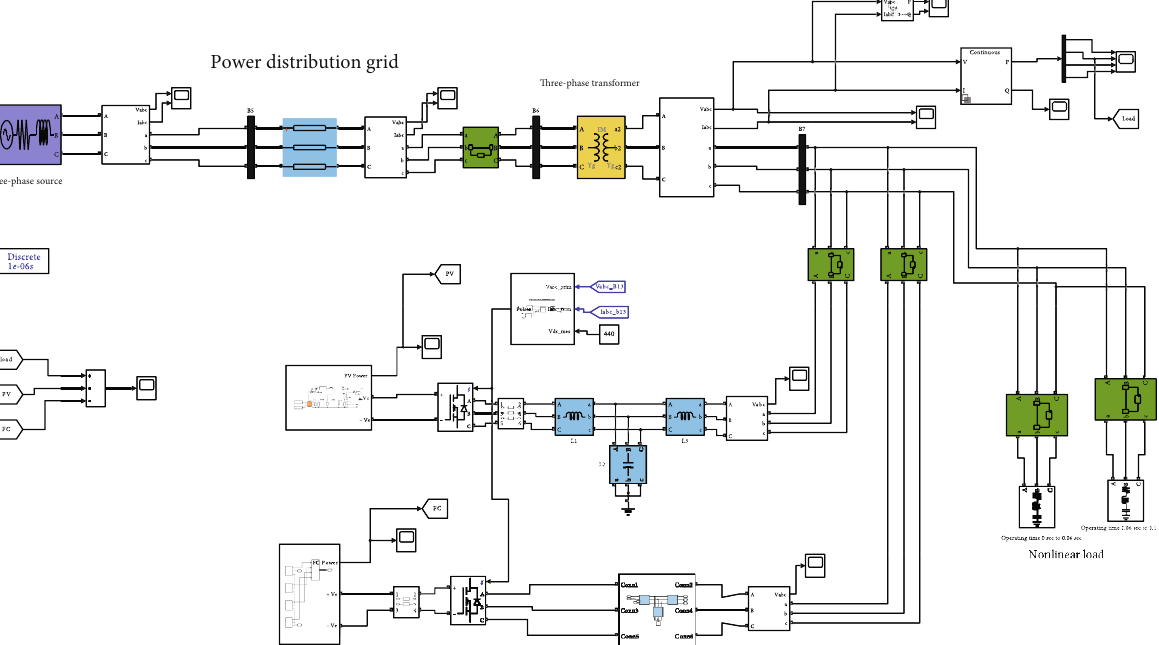
Figure 21: The proposed simulation model of a DNN-based controller with a microgrid integrated with a hybrid PV and a FC energy system.